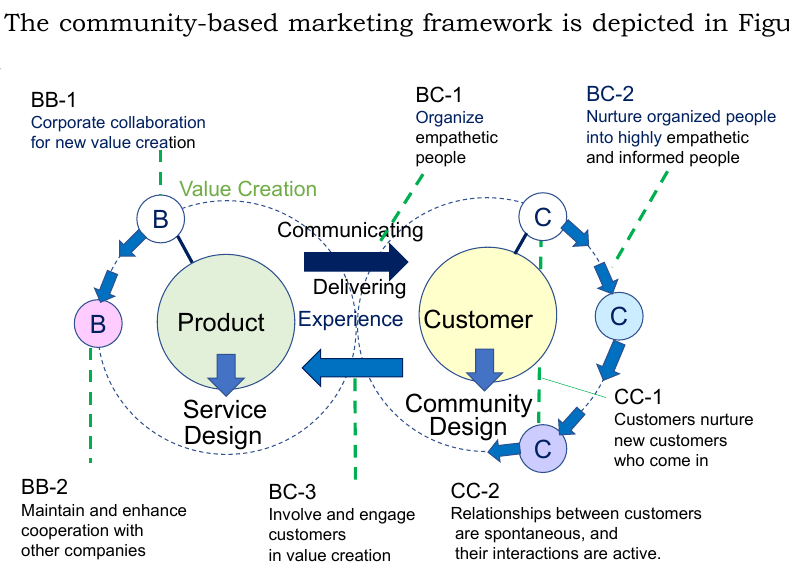
Figure 2. The concept of “community-based marketing” as a new way of perceiving